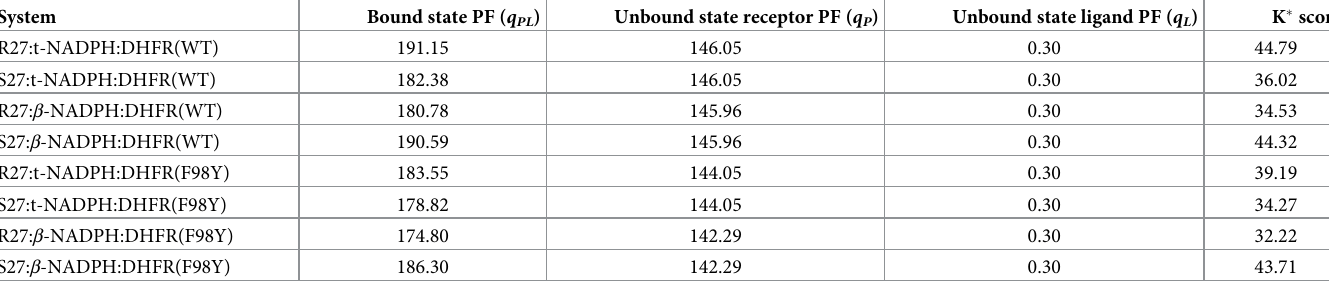
All PF and K � scores in this table are log 10